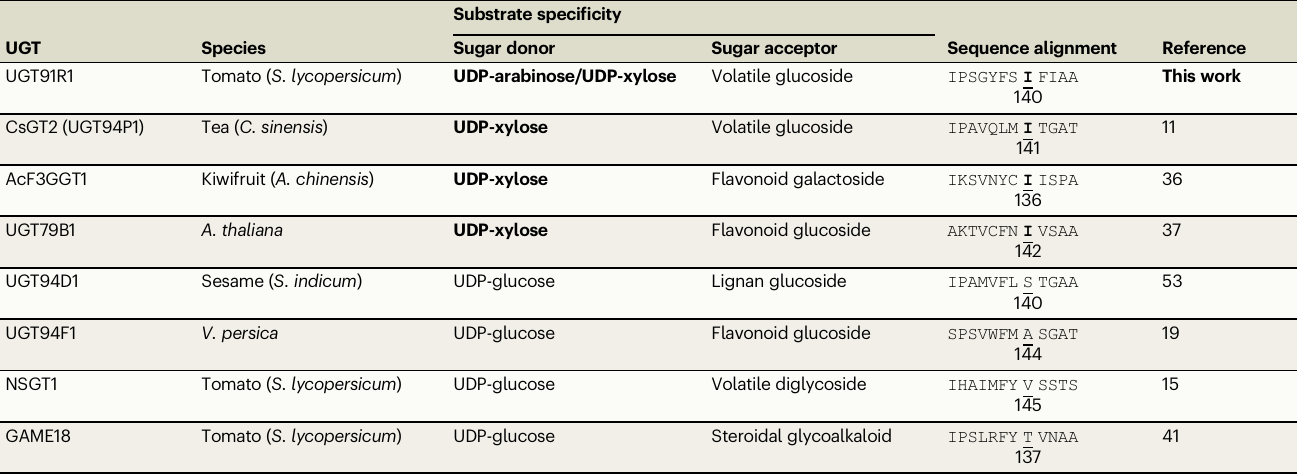
Table 3 | Comparison of substrate speci fi city of